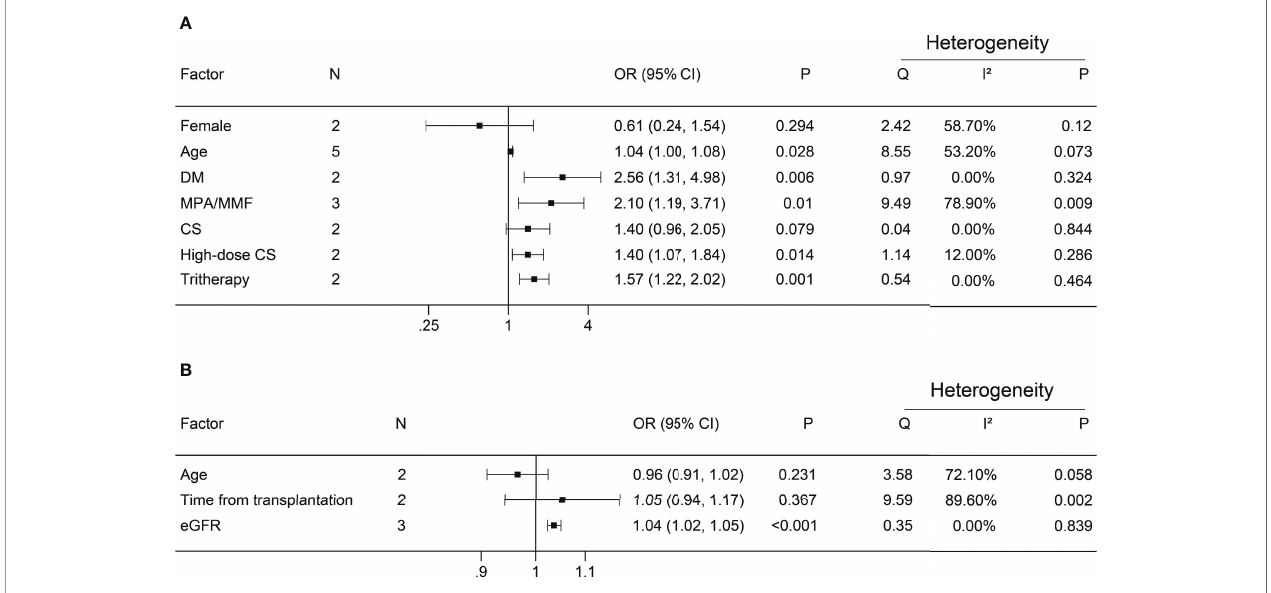
FIGURE 4 | Forest plots of multivariate analysis. (A) Factors associated with a negative antibody response; (B) Factors associated with positive antibody response. N, number of studies; DM, diabetes mellitus; MPA/MMF, mycophenolic acid or mycophenolate mofetil; CS, corticosteroids; tritherapy, triple immunosuppressive therapy; eGFR, estimated glomerular fi ltration